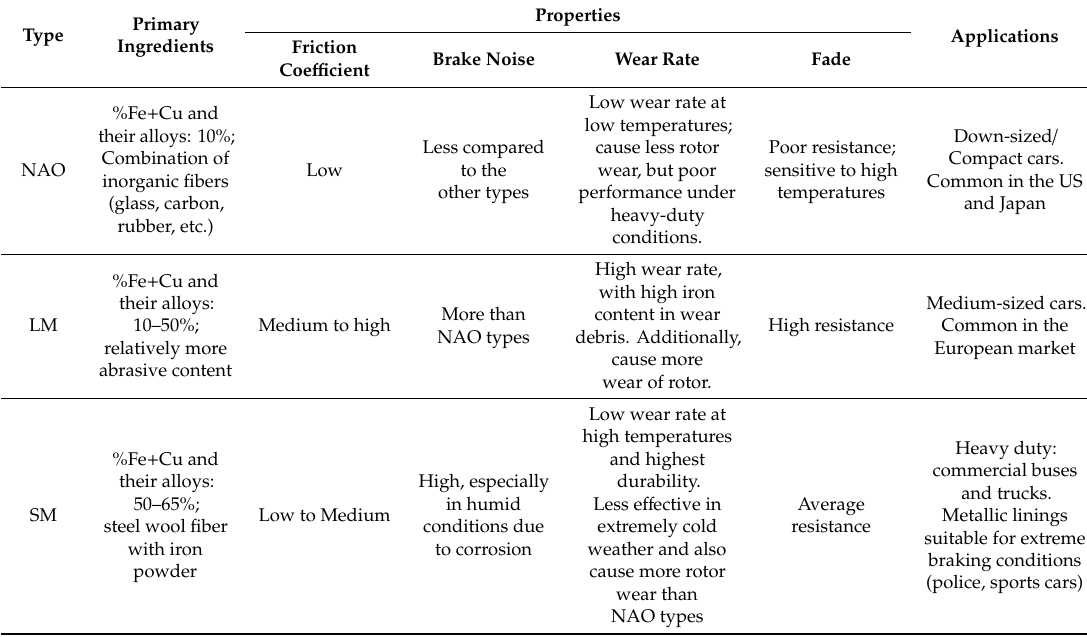
Table 1. Brake pads: Types and general properties [6,13,24,28,37,45,48,59].